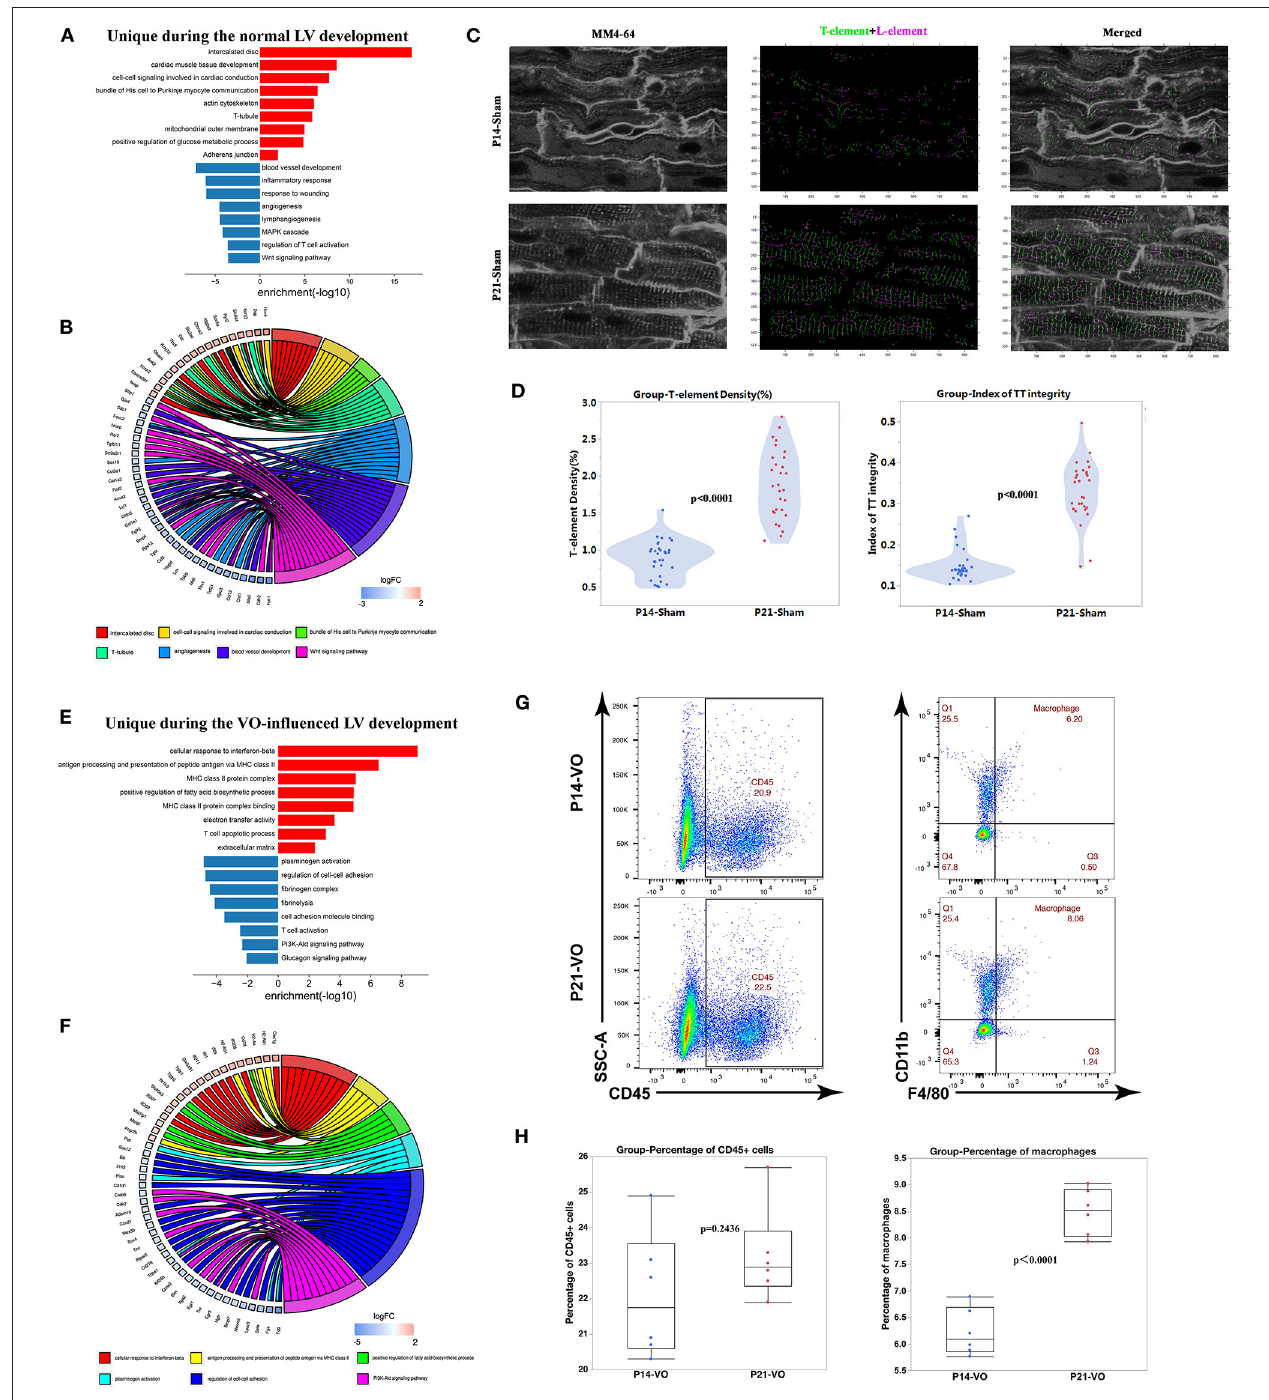
FIGURE 5 | The unique developmental processes separating normal left ventricles (LVs) from volume overload (VO)-influenced LVs. (A) Genes uniquely appearing in the Sham comparison were subjected to GO and KEGG pathway analysis. (B) Circle plot of select genes indicated ontologies of Sham comparison. Gene expression relative difference (log2 fold change). (C) Left panel: representative of T-tubules from P14_Sham and P21_Sham groups. MM4-64 (T-tubule, white); middle panel: skeletalization of T-tubule system, T-element (green), and L-element (purple); right panel: merged. (D) Left panel: quantification of T-element density from 30 cardiomyocytes in each group; right panel: quantification of the index of TT integrity from 30 cardiomyocytes in each group. (E) Genes uniquely appearing in the VO comparison were subjected to GO and KEGG pathway analysis. (F) Circle plot of select genes indicated ontologies of VO comparison. Gene expression relative difference (log2 fold change). (G) Representative flow cytometry plots of CD45 + cells among singlets and macrophages (CD11b + F4/80 + ) among CD45 + cells. (H) Frequency quantification of the percentages of CD45 + cells and macrophages, n = 6, Student’s t -test.